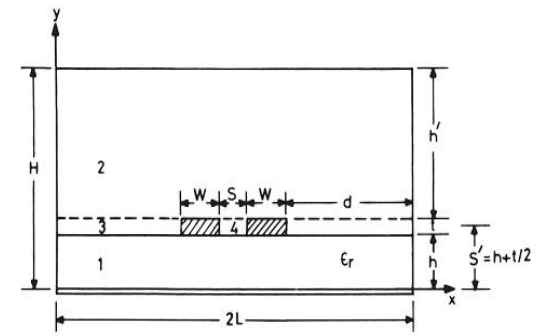
Figure 3: Symmetric coupled microstrip lines in an enclosure [3].